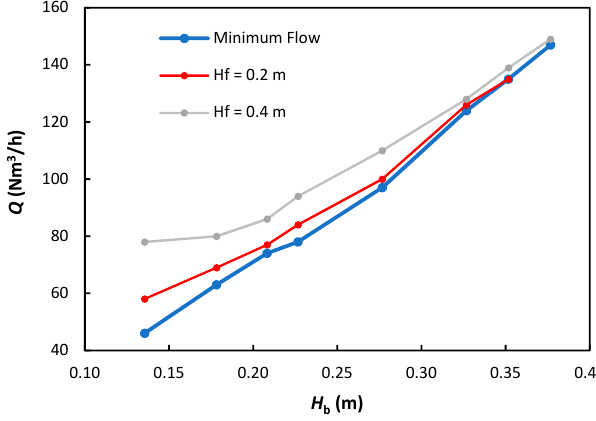
Figure 3. Operational gas flow rates at different bed depths.